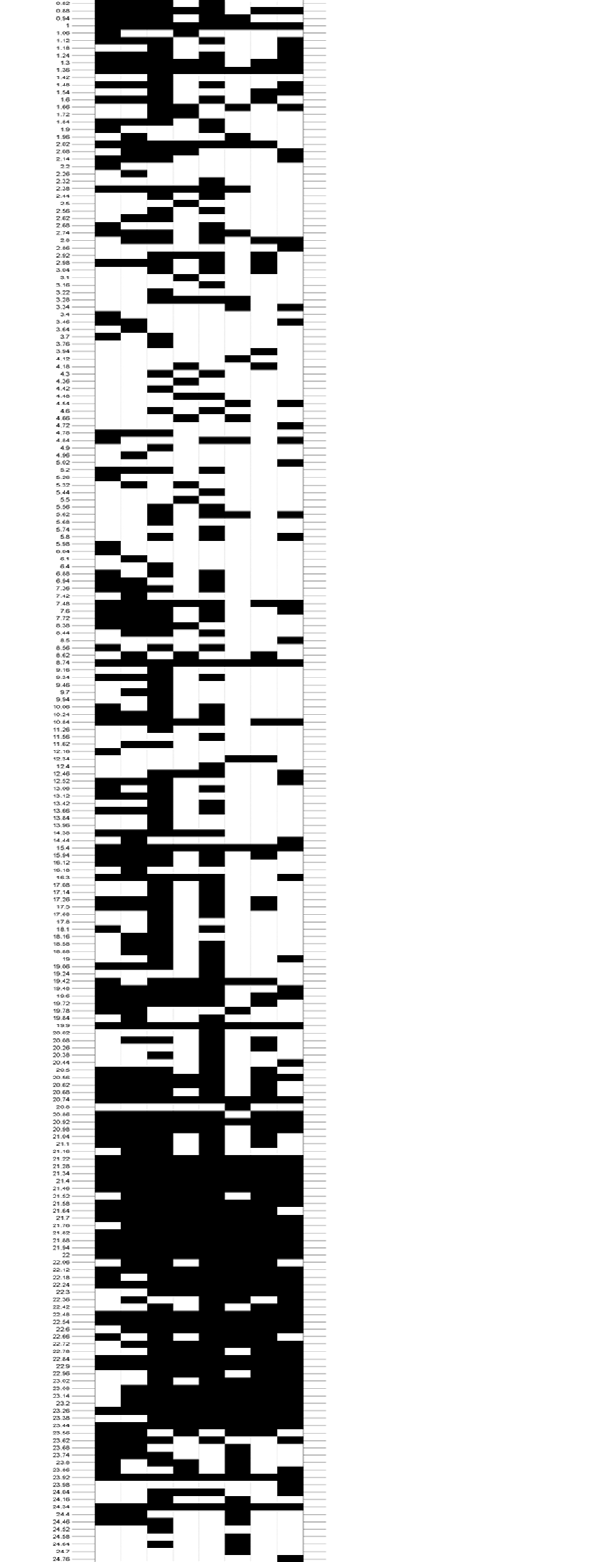
Figure 6. Binary plot illustrating the GC-FID chromatographic peaks (metabolites) associated with each SPME fiber. Columns represent the fibers while rows indicate peak retention times. Each extraction was performed in duplicate and replicates combined. Fiber legend: A - 75 m m CAR-PDMS, B - 85 m m CAR-PDMS, C - 50/30 m m CAR- DVB-PDMS, D - 85 m m PA, E - 65 m m DVB-PDMS, F - 7 m m PDMS, G -